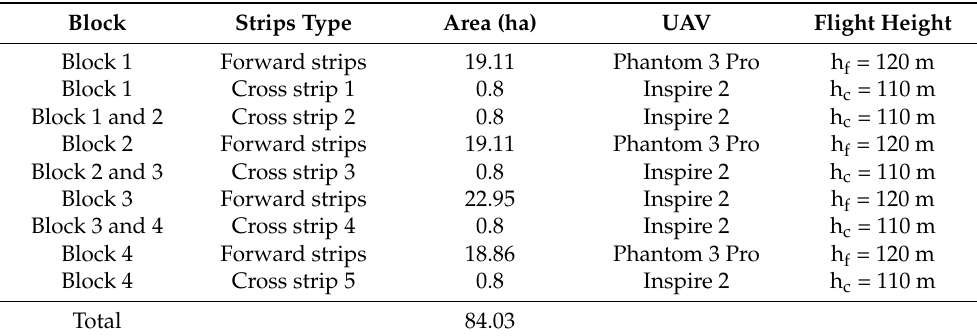
Table 2. Area in hectares for each block studied; h f refers to the forward flight height, and h c refers to cross flight